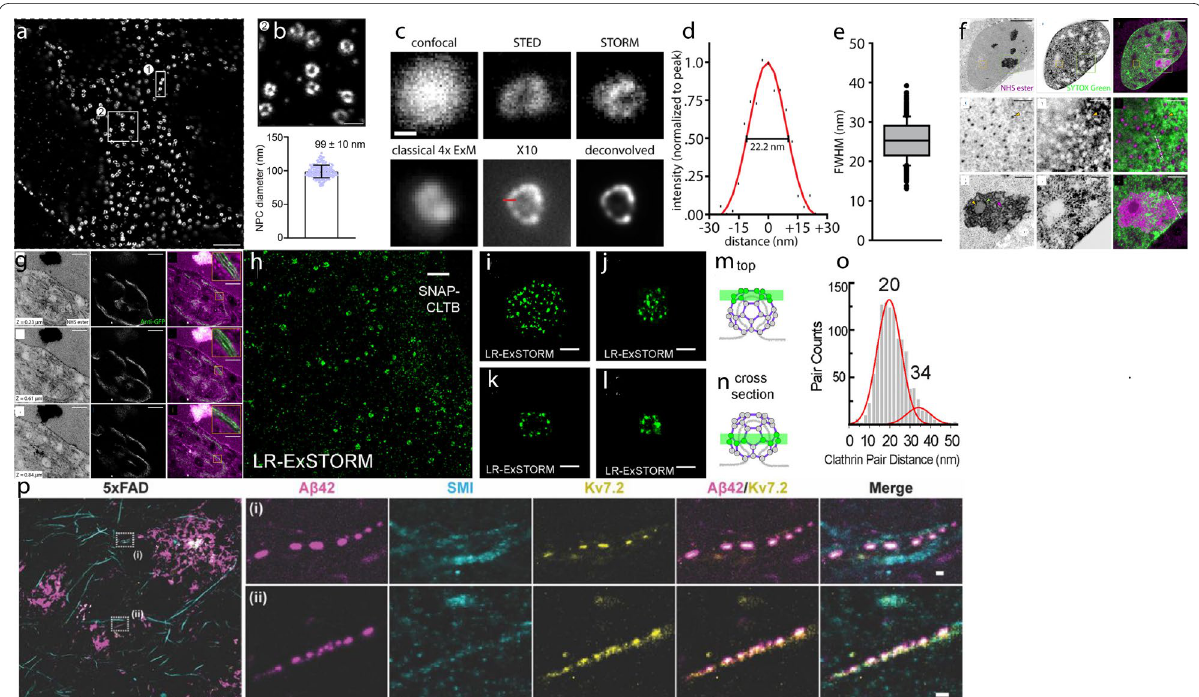
Fig. 15 High-resolution images obtained with high-expansion-factor ExM variants. a Nucleus imaged by confocal microscopy after TREx. Scale bar, 1 μm. b High-resolution view of several nuclear pores from boxed region (2) of a and the distribution of diameters of individual nuclear pores. Scale bar, 200 nm. c Immunostainings for the peroxisome membrane protein Pmp70 in neurons by both super-resolution and X10 Expansion Microscopy. Scale bar, 100 nm. d The exemplary line scan from the X10 Expansion Microscopy image in c is shown with a best Gaussian fit curve. e Quantification of the average resolution of X10 Expansion Microscopy image, which is 25.2 0.2 nm. f pan-ExM reveals nuclear architecture in ± interphase. Image of SYTOX Green nucleic acid stain (middle column) and NHS ester pan-stained sample (left column) and overlay of them (right column). Scale bars, (top row) 5 μm, (middle row) 250 nm, (bottom row), 1 μm. g Overlay of the NHS ester and anti-GFP images. The insets show the zoom-in yellow boxes and reveal individual ManII-positive Golgi cisternae. Scale bars, 2 μm. h Label-retention expansion STORM (LR-ExSTORM) image of a HeLa cell overexpressing SNAP-CLTB, stained with BG-MA-biotin, and post expansion labeled with streptavidin-AF647. Scale bar, 2 μm. i , j Images of x–y cross sections at the top of single CCPs as illustrated in m . Scale bar, 100 nm. k , l Images of x–y cross sections in the middle of